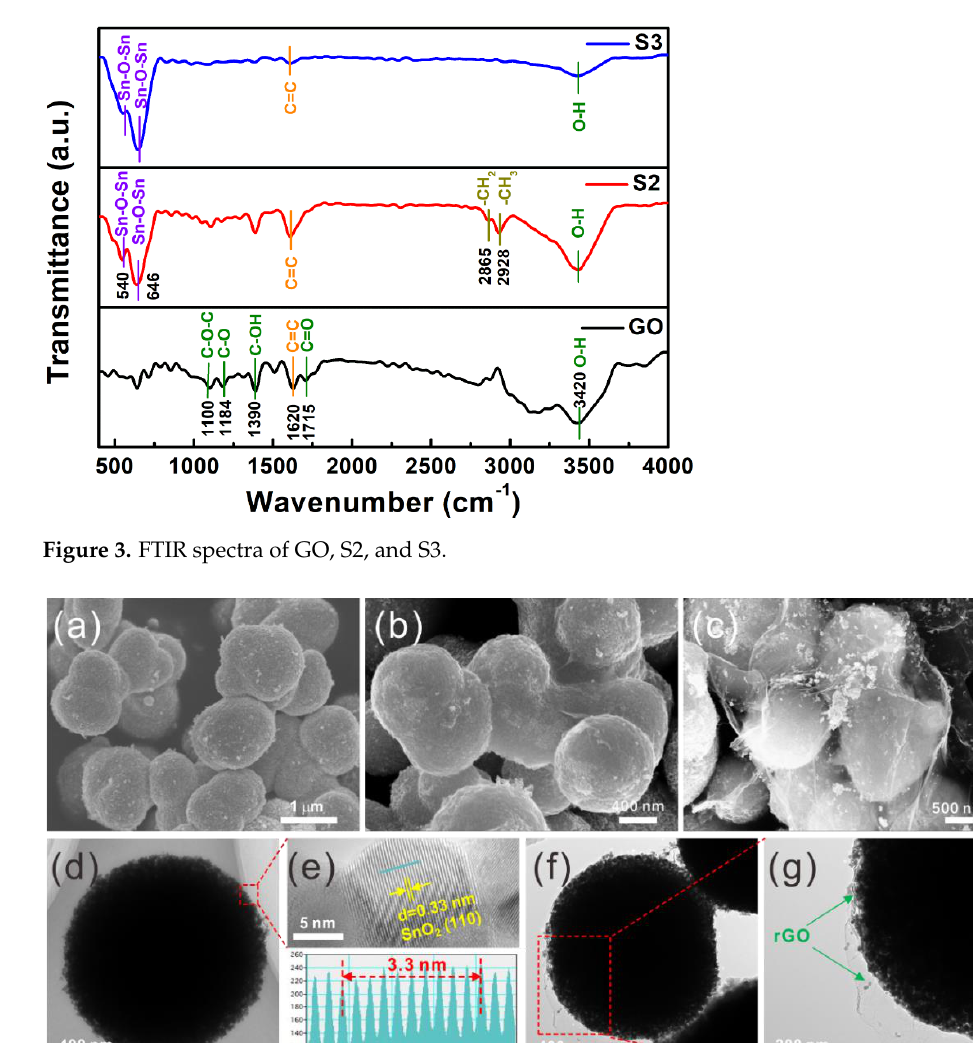
Figure 3. FTIR spectra of GO, S2, and S3.